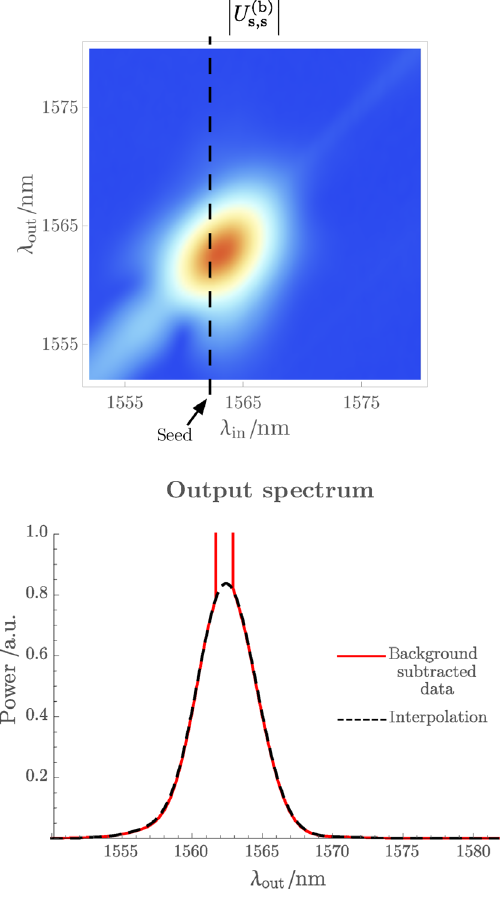
FIG. 11. (a) Reconstruction of the stimulated emission spec- trum as a function of seeding wavelength, measured in the seed polarization. Color indicates the absolute value of the field (square root of the measured spectral power density). (b) The red line represents one “ slice ” of the background subtracted data, showing a noisy measurement around the seed wavelength, where the OSA detector is blinded by the seed; the black line is the reconstructed spectrum obtained by interpolating over the noisy